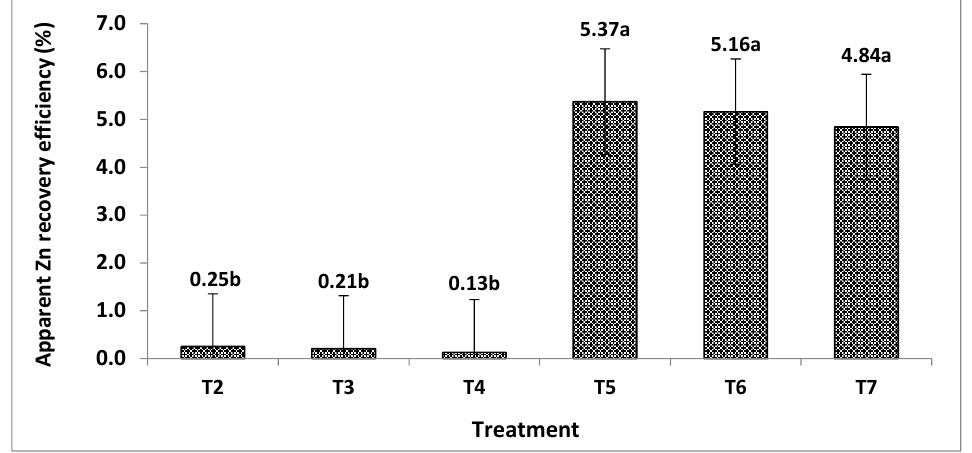
Figure 1. Effect of zinc fertilizer and zinc oxide nanoparticles on apparent zinc recovery efficiency of tomato in soil condition. Means followed by common letter(s) are not significantly different from each other at 5% level of significance. Note: T 2 = 1500 ppm Zn nutrient, T 3 = 2000 ppm Zn nutrient, T 4 = 2500 ppm Zn nutrient, T 5 = 75 ppm ZnO nanoparticle, T 6 = 100 ppm ZnO nanoparticle, and T 7 = 125 ppm ZnO